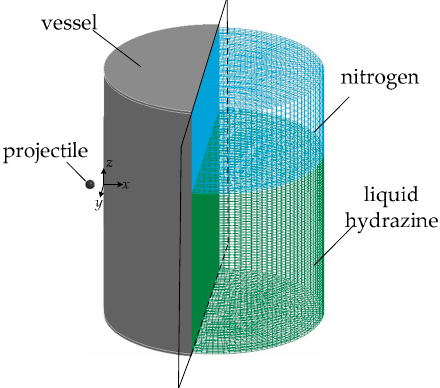
Figure 4. The simulation model of HYP-2 test device and the right side is the inside view with the vessel wall removed.